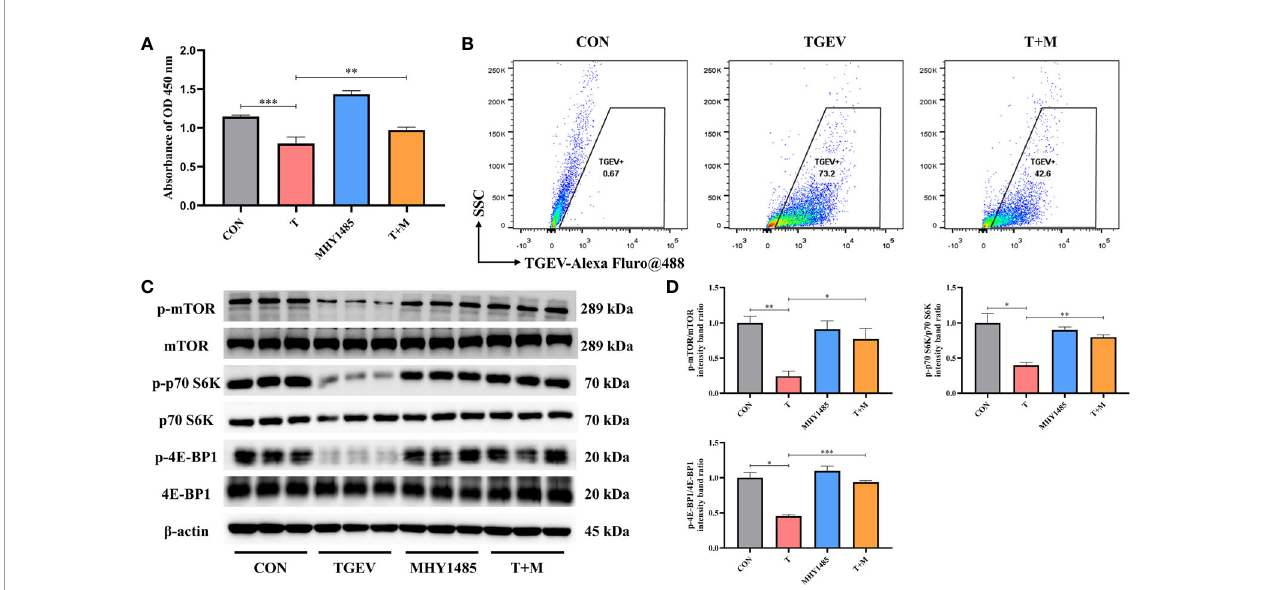
FIGURE 3 | MHY1485 attenuated the TGEV infection by activating mTOR signaling. (A) CCK-8 assay was used to detect the proliferation of IPEC-J2 cells pretreated with 10 m M MHY1485, followed by TGEV infection. Data express the mean ± SEM (n = 3). (B) The contents of TGEV were analyzed via fl ow cytometry in the IPEC-J2 cells pretreated with 10 m M MHY1485, followed by TGEV infection. (C) The protein levels of p-mTOR, mTOR, p-p70 S6K, p70 S6K, p-4E-BP1 and 4E- BP-1 were detected by western blot. (D) Quantitation of bands to demonstrate the protein level of p-mTOR/mTOR, p-p70 S6K/p70 S6K and p-4E-BP1. Data express the means ± SEMs (n = 3). The symbol * indicates statistically signi fi cant differences (P < 0.05), ** P < 0.01 and *** P < 0.001.